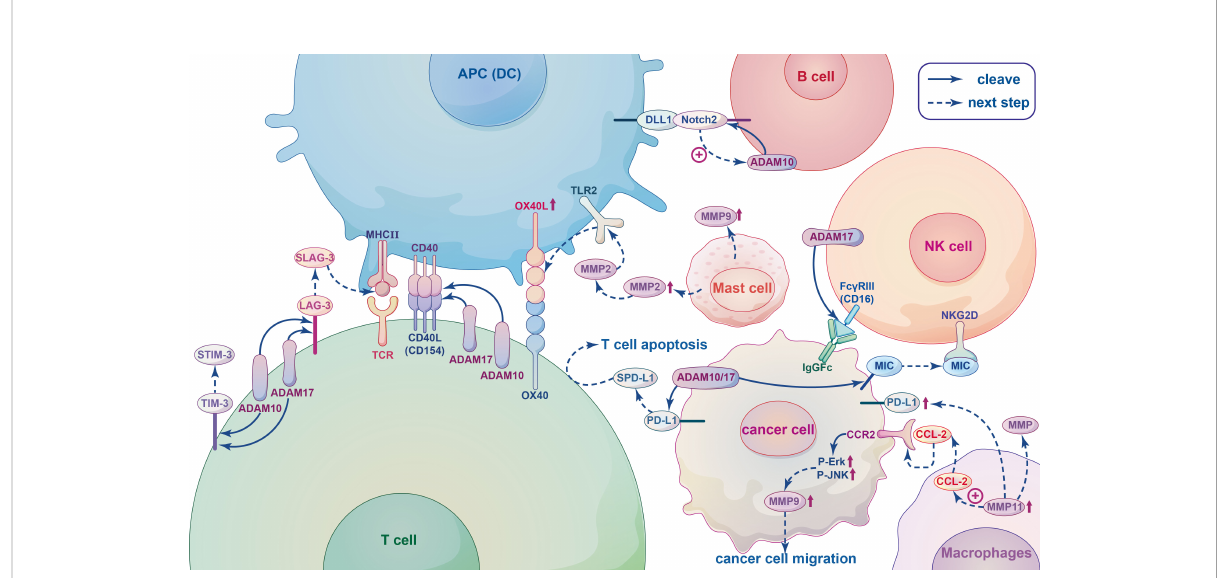
FIGURE 4 The relationship between metalloproteinases and immune cells. When T-cell receptor (TCR) of T cells interact with the major histocompatibility complex (MHC II) of antigen presenting cells (APCs), co-stimulatory receptor CD40L(CD154) expression is rapidly upregulated and linked to CD40, and subsequently released from the T cell surface by cleavage by ADAM10 and ADAM17. Lymphocyte Activation Gene-3 (LAG-3), T-cell immunoglobulin and mucin domain-containing protein-3 (TIM-3) are T-cell coinhibitory receptors can be cleaved by ADAM10 and ADAM17 yielding soluble form sLAG-3 and sTIM-3. SLAG-3 binds to MHCII inhibiting the activation of T cells and inducing dendritic cell maturation, sTIM-3 can impair the antitumor immune response of T cells. ADAM10 and ADAM17 can both produce different cleavage products of PD-L1, which called soluble PD-L1 (sPD-L1) and shed from the surface of tumor cells, inducing apoptosis of CD8+ T cells and inhibiting antitumor immunity. In B cells, Notch2 heterodimers bind to ligands DLL1 presented on antigen presenting cells (APCs), which initiates ADAM10 resulting in the release of the Notch intracellular domain that translocating to the nucleus to trigger the expression of downstream target genes. The IgG Fc receptor Fc g RIII (CD16), recognizing blinding the Fc part of the IgG antibody of tumor cells and dissolving the cells by Ab-dependent cell- mediated cytotoxicity (ADCC), on NK cells can be cleaved by the metalloprotease ADAM17, leading to NK cell dysfunction and reduced ADCC capacity. MMPs and ADAMs can cleave ligands of the activated receptor NKG2D, such as MIC, on the surface of tumor cells, they bind to NKG2D inducing endocytosis this receptor and causing tumors to evade immune surveillance. Tumour-associated macrophages (TAM) can secret MMPs to promote tumor angiogenesis, invasion and regulate immune response. The chemokine CCL2 secreted by MMP11- overexpressing macrophages activates MAPK pathway, including Phosphorylation of ERK1/2 and JNK, through combined with its receptor CCR2, thereby promoting the migration of cancer cells by up-regulating MMP9. MMP11-expressing macrophages can also upregulate PD-L1 expression and induce immunosuppression of cancer cells. MMP2 and MMP9 released by mast cells (MCs) can promote tumor angiogenesis and tumor invasiveness, respectively. MMP2 as a physiological TLR2 ligand can speci fi cally trigger TLR2 and then increase OX40 ligand (OX40L), which interacted with OX40, on dendritic cells (DCs) to drive T cell responses leading to modulation of immune